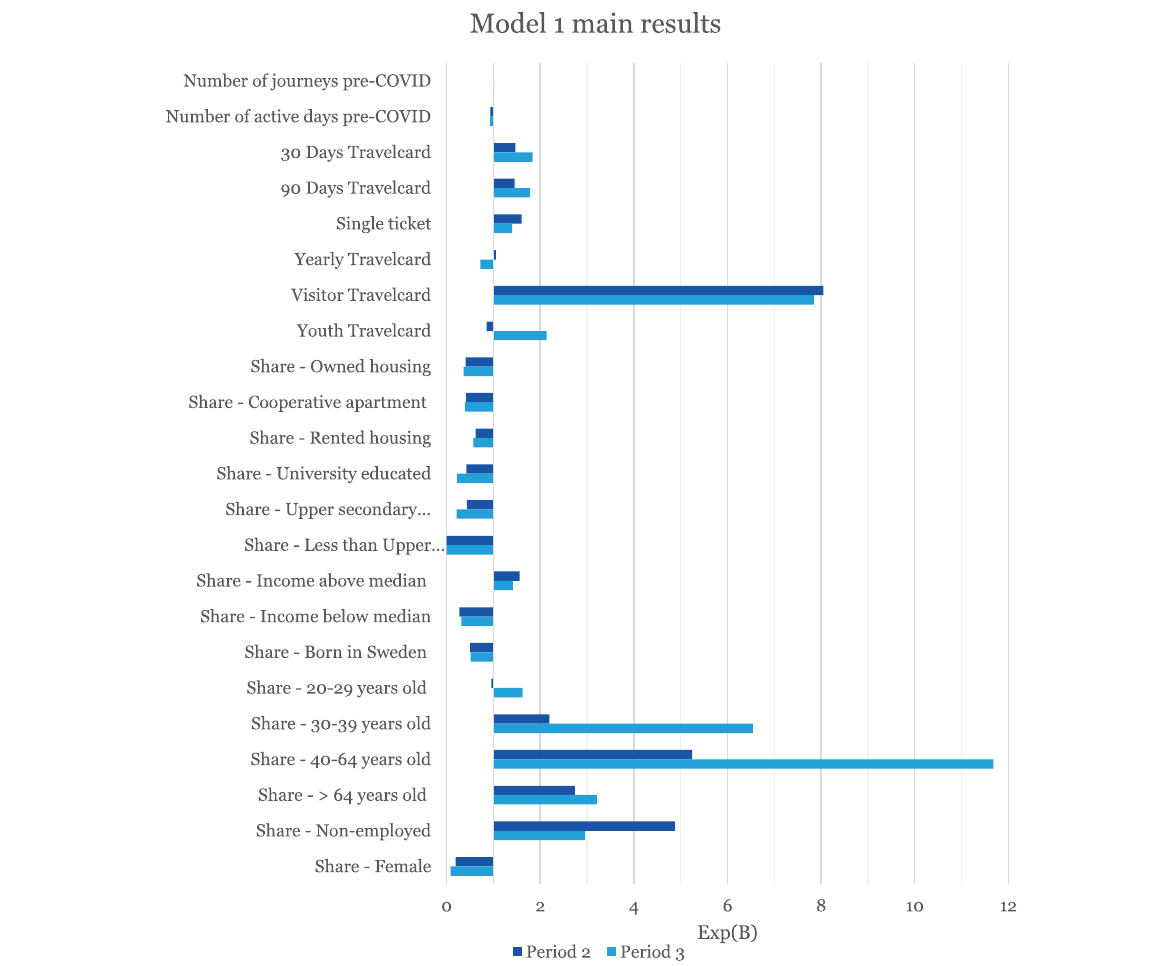
Fig. 4 The main results of Model 1 estimations. All parameters are significant at the 5% level, except the Share of 20 – 29 year olds for Period 1. Note the difference in scale between Figs. 4 and 5. See the Additional file 1 for